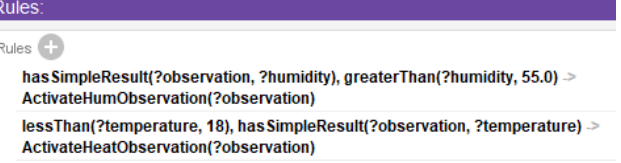
Figure 6. Scenario 3-based SWRL rules in SmartMuseumOnto (depicted in Protégé